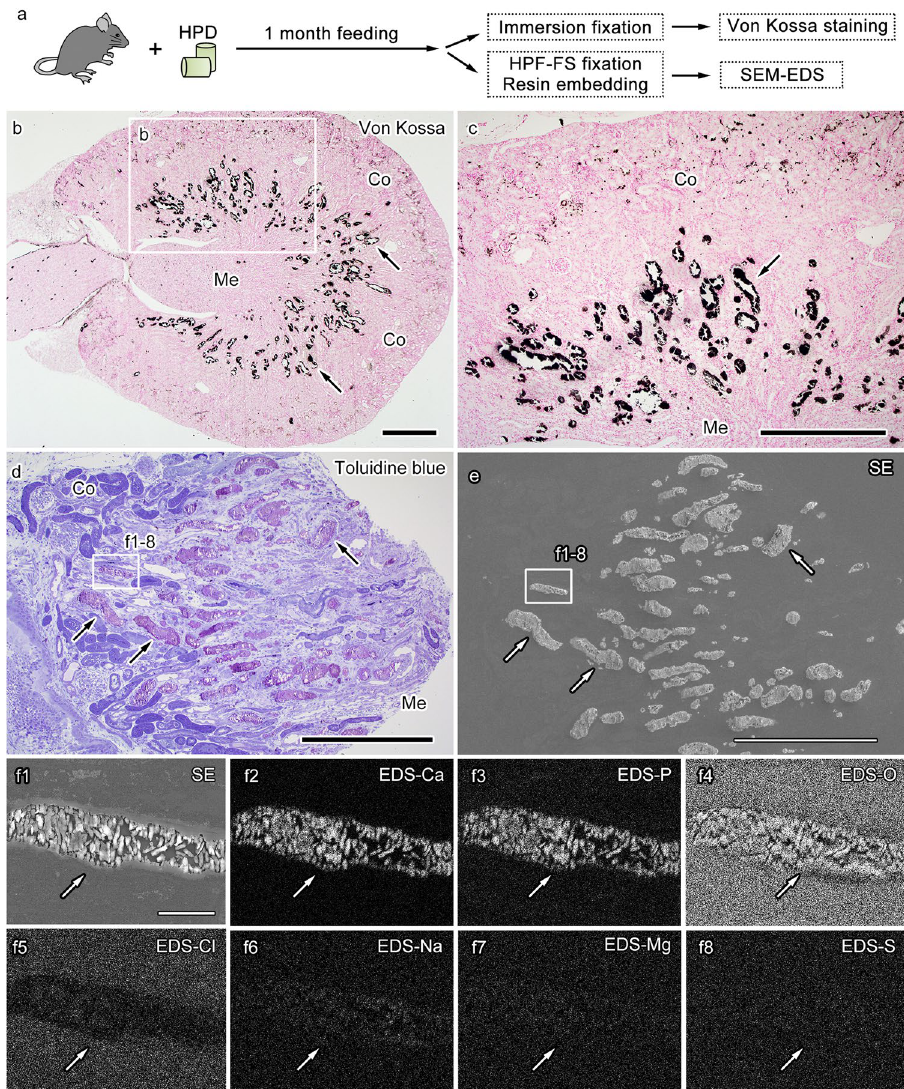
Figure 1. Calcium phosphate particle (CaP) detection in the corticomedullary junction of the kidney under a 4-week high-phosphate diet (HPD). Schematic drawing of the experimental design, including high-pressure freezing followed by freeze substitution (HPF-FS) and scanning electron microscopy (SEM) with energy- dispersive X-ray spectroscopy (EDS) ( a ). A representative image of an HPD-fed mouse kidney section stained using von Kossa staining ( b ). The marked area ( b ) is magnified ( c ) in von Kossa staining, and silver salt is detected in the corticomedullary junction between the renal cortex (Co) and medulla (Me) ( b , c , arrows). A semi-thin resin section of the corticomedullary junction stained with toluidine blue ( d ) shows profiles with metachromasia ( d , arrows) in areas between Co and Me. The corresponding profiles are indicated in the secondary electron image (SE) obtained from the serial section ( e , arrows). In the area marked with a rectangle ( d , e ), the EDS analyses of the profile ( f1 , arrow) at a higher magnification demonstrating calcium (Ca, f2 , arrow), phosphorus (P, f3 , arrow), and oxygen (O, f4 , arrow) signals, although little signals of chlorine (Cl, f5 , arrow), sodium (Na, f6, arrow), magnesium (Mg, f7 , arrow), and sulfur (S, f8 , arrow). Scale bars: 500-μm ( b – e ) and 30-μm ( f1 – f8